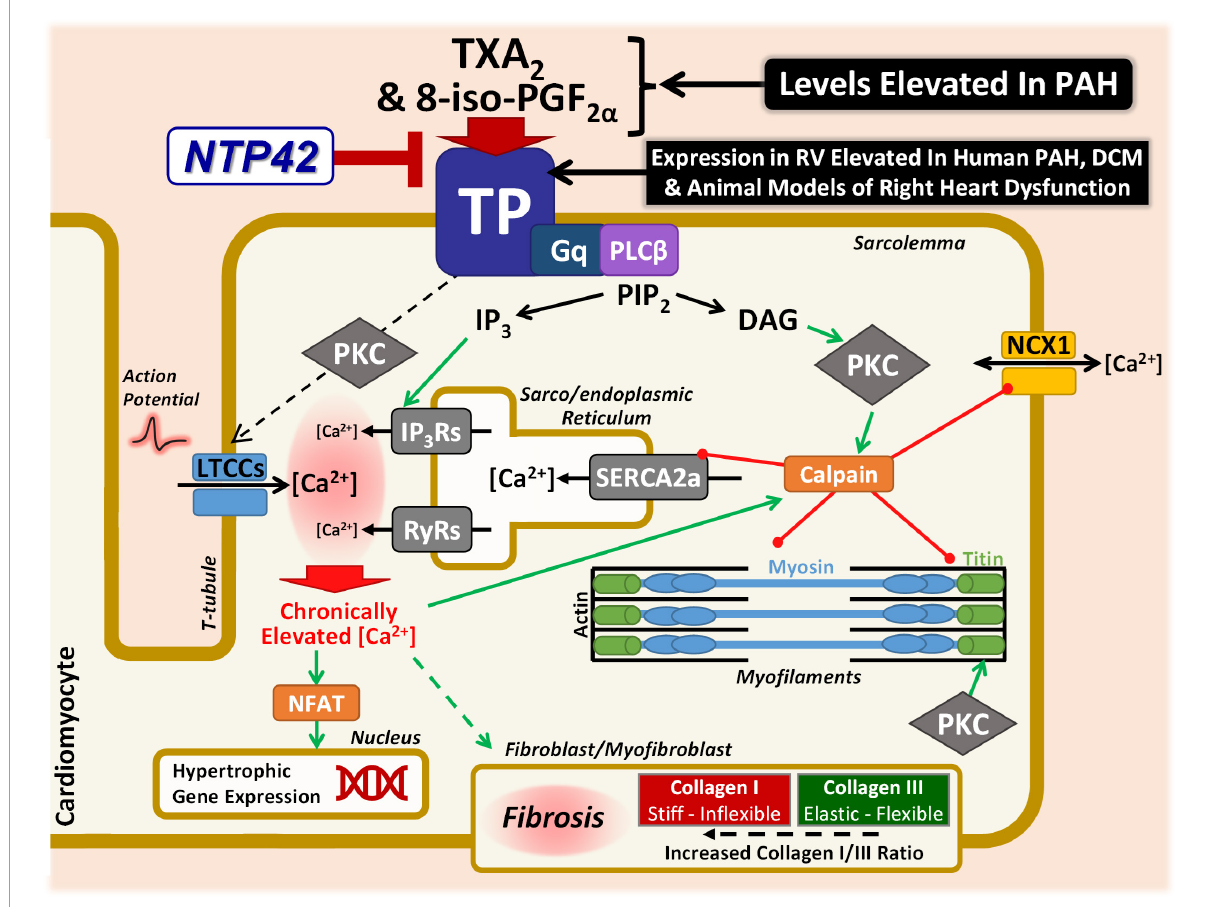
FIGURE8 Specific antagonism of TP signaling may alleviate key mechanisms involved in cardiac dysfunction in PAH and other cardiac conditions. Schematic representation focusing on the potential mechanisms through which the TXA 2 /TP signaling axis may lead to cardiac dysfunction in PAH and other cardiac conditions. Signaling through the Gq-coupled TP leads to PLC β activation, liberating IP 3 and DAG from PIP 2 . IP 3 release mobilizes Ca 2 + from the sarco/endoplasmic reticulum via IP 3 R activation. IP 3 -mobilized Ca 2 + , along with extracellular Ca 2 + influx via LTCCs, triggers a larger Ca 2 + release via RyRs. LTCC-mediated Ca 2 + influx may also occur via a TP-mediated PKC mechanism. Chronically elevated Ca 2 + leads to hypertrophic signaling via NFAT. Ca 2 + overload also activates the protease calpain, which degrades myofibrillar proteins